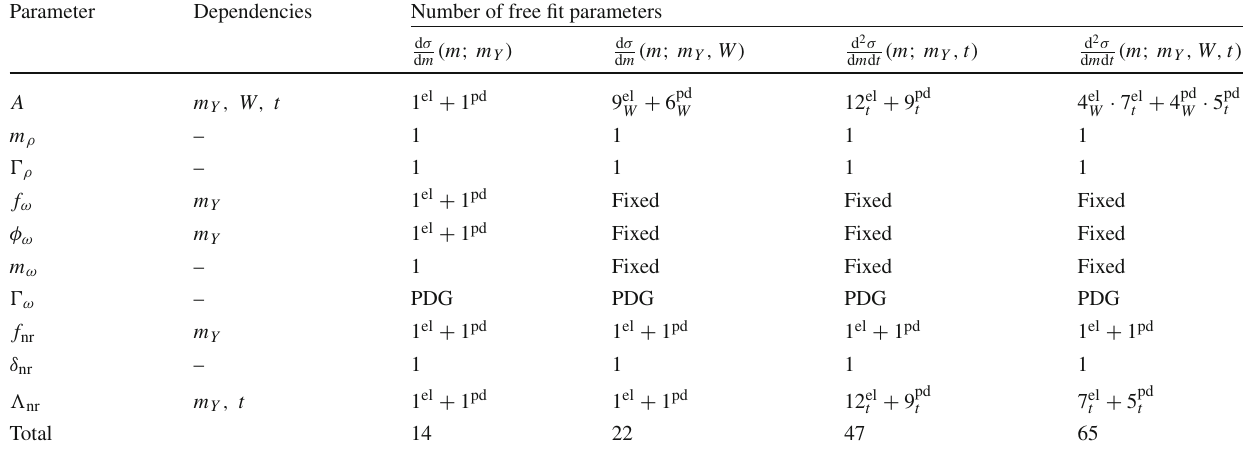
Table 1 Parameter assumptions and resulting number of parameters used to fit Eq. (18) to the invariant π + π − mass distributions. The num- ber of parameters depends on the number of bins in the extracted cross sections. The number of bins in which a parameter is fitted freely is given and the corresponding distribution indicated by sub- and super-